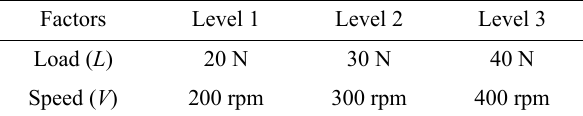
Table 4 Factors and their associated levels.